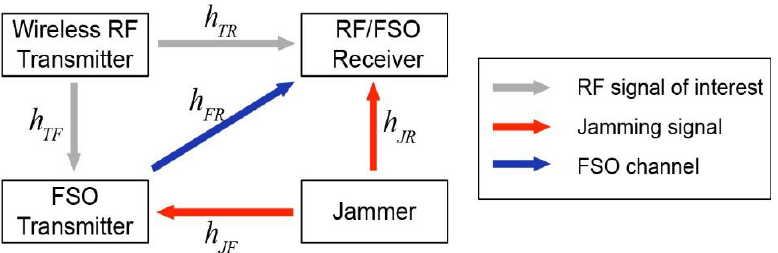
Figure 3. Schematic diagram of the anti-jamming system. The free space optical (FSO) transmitter receives both of the signal of interest from the wireless RF transmitter (grey arrow) and the jamming signal from the jammer (red arrow). The FSO transmitter modulates both of the signals on optical carriers, and sends the signals to the FSO receiver through FSO channel (blue arrow).